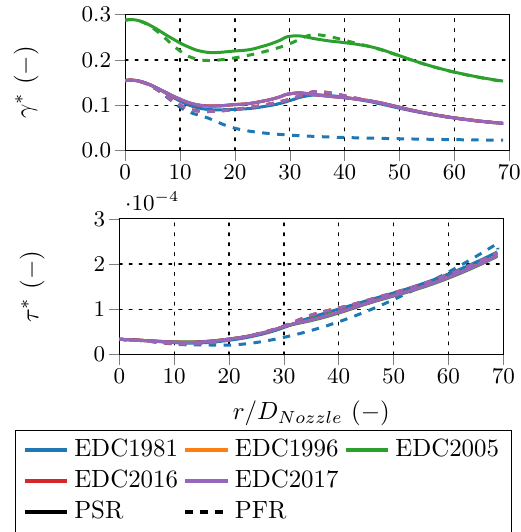
Figure 12. Fine structure share ( γ ∗ ) and fine structure residence time ( τ ∗ ) along the center axis of flame D for all EDC model variations. Not all EDC versions are visible due to overlapping